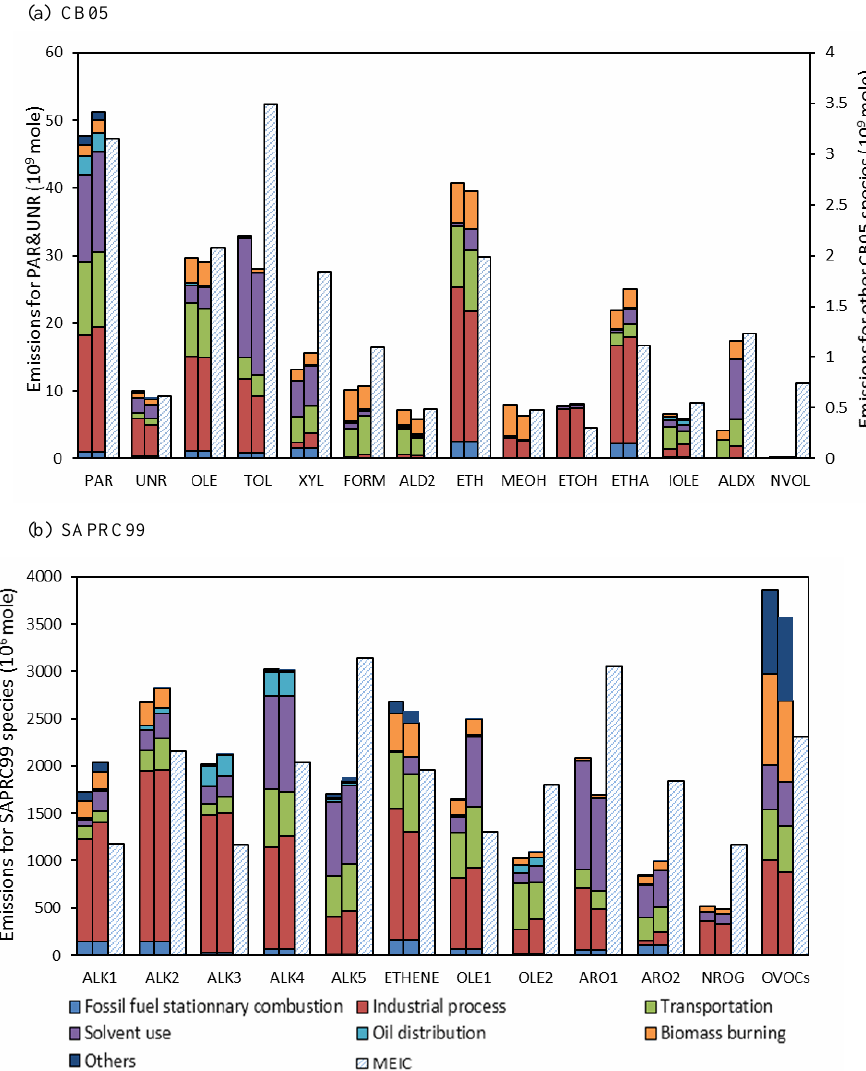
Figure 7. Emissions of CB05 (a) and SAPRC99 (b) species for Jiangsu in 2010. The left and middle columns indicate the results before and after updating of source profiles, and the right columns indicate the results of MEIC. The CB05 species PAR stands for the paraffin carbon bond, UNR for unreactive parts of molecules, OLE for terminal olefin carbon bond, TOL for toluene and other monoalkyl aromatics, XYL for xylene and other polyalkyl aromatics, FORM for formaldehyde, ALD2 for acetaldehyde, ETH for ethene, MEOH for methanol, ETOH for ethanol, ETHA for ethane, IOLE for internal olefin carbon bond, ALDX for C3 + aldehydes and NVOL for non-volatile mass. The SAPRC 99 species ALK1, ALK2, ALK3, ALK4 and ALK5 represent alkanes and other non-aromatic compounds that react only with OH and have kOH between 2 and 500, 500 and 2500, 2500 and 5000, 5000 and 10000, and greater than 10000ppm − 1 min − 1 , respectively. ETHENE stands for ethane and OLE1 for alkenes with kOH smaller than 70000ppm − 1 min − 1 , OLE2 for alkenes with kOH greater than 70000ppm − 1 min − 1 , ARO1 for aromatics with kOH smaller than 20000ppm − 1 min − 1 , ARO2 for aromatics with kOH greater than 20000ppm − 1 min − 1 and NROG for unreactive